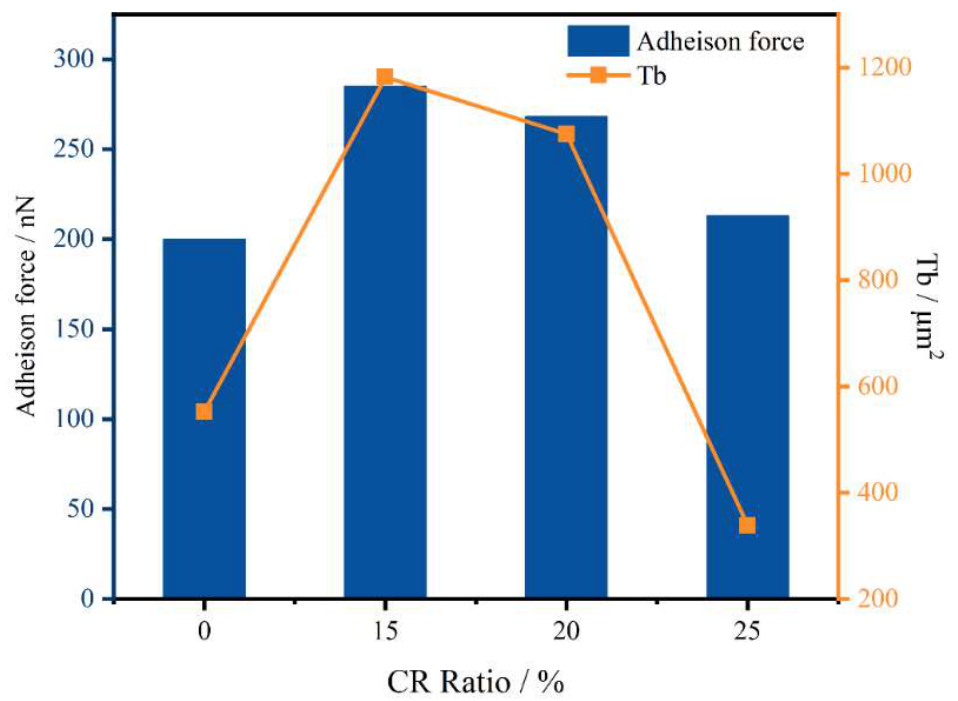
Figure 13. Adhesion force and catanaphase shape parameters.